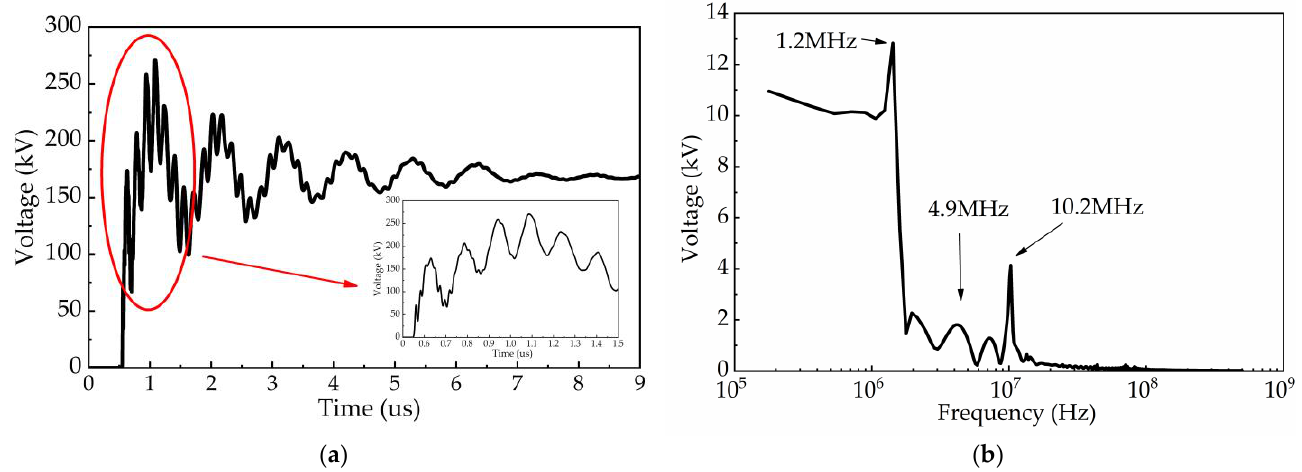
Figure 18. The simulation results of VFTO in time domain and frequency domain. ( a ) Time-domain simulation results; ( b ) Frequency-domain simulation results.